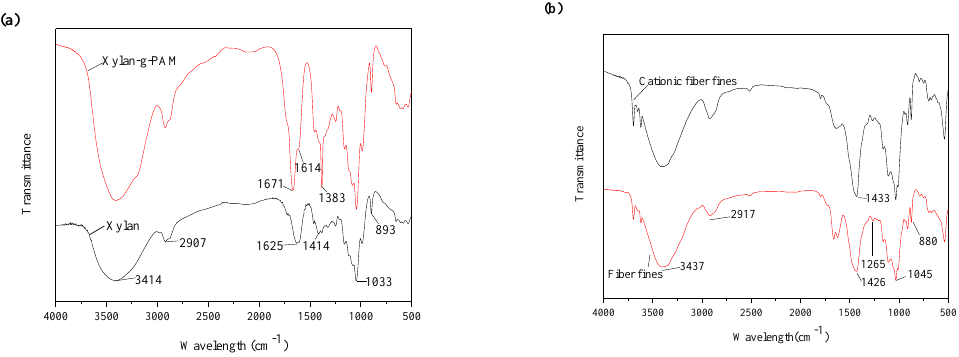
Figure 2. FTIR spectra of xylan and xylan-g-PAM ( a ); fiber fines and cationic fiber fines ( b ).